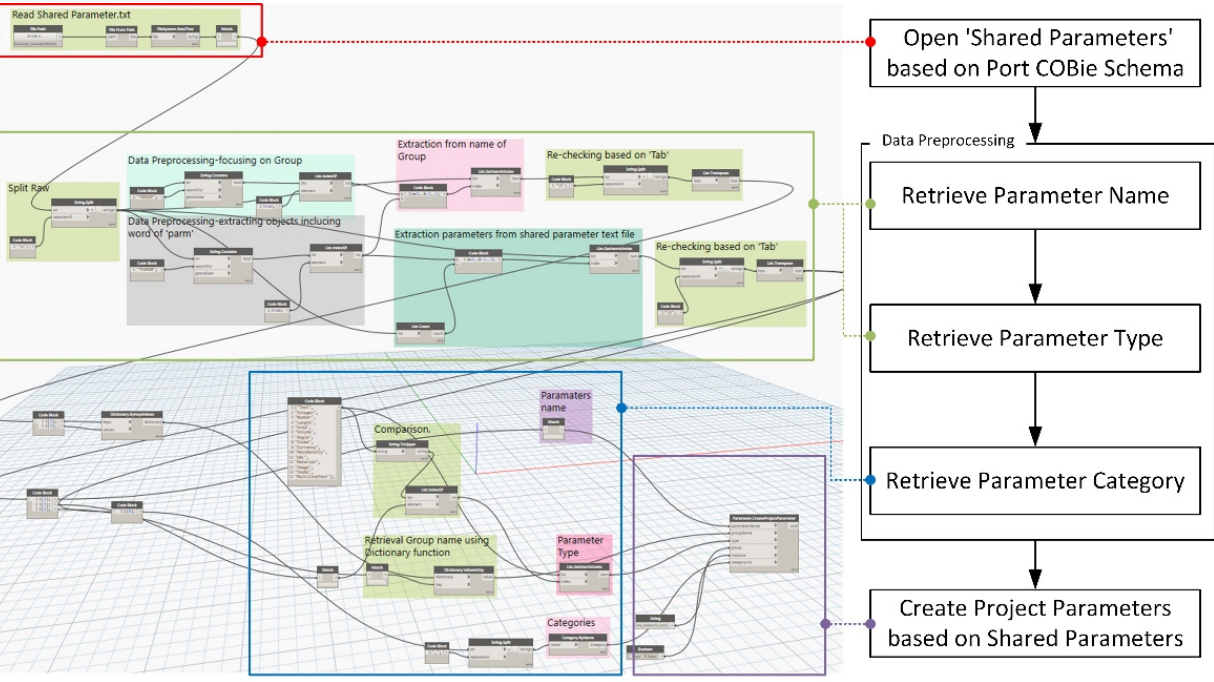
Figure 16. COBie system with project parameters.